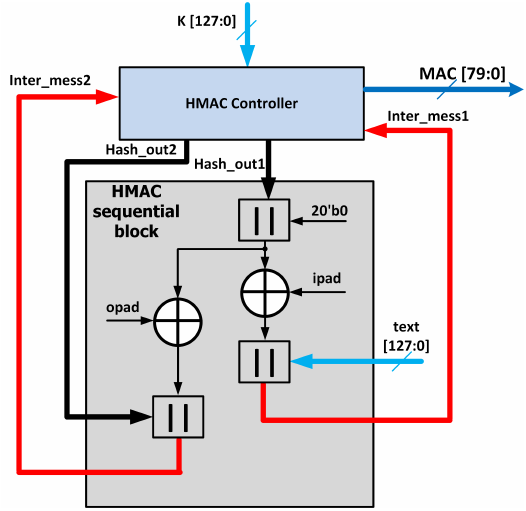
Figure 8. The proposed hardware architecture of